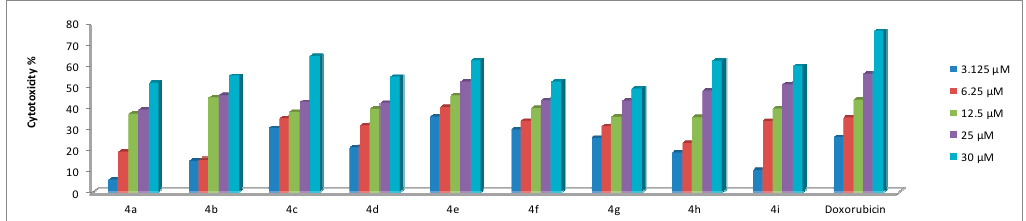
Figure 4. Dose dependent cytotoxic activities of new compounds on MCF-7 cancer cells according to the MTT assay.